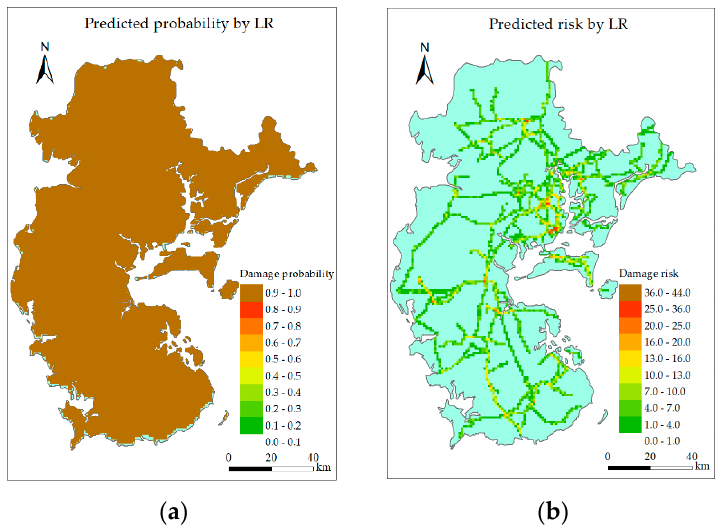
Figure 15. Prediction results of LR. ( a ) Predicted damage probability. ( b ) Predicted damage risk.